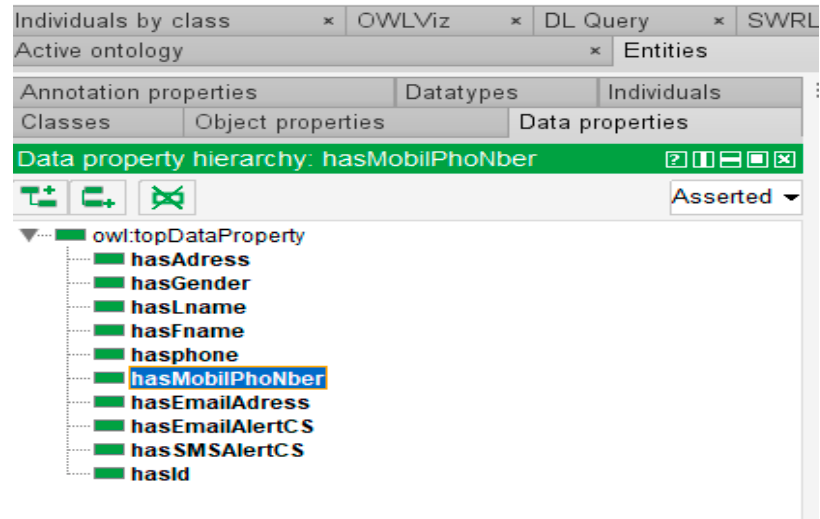
Figure 19. Data properties of the detection system.